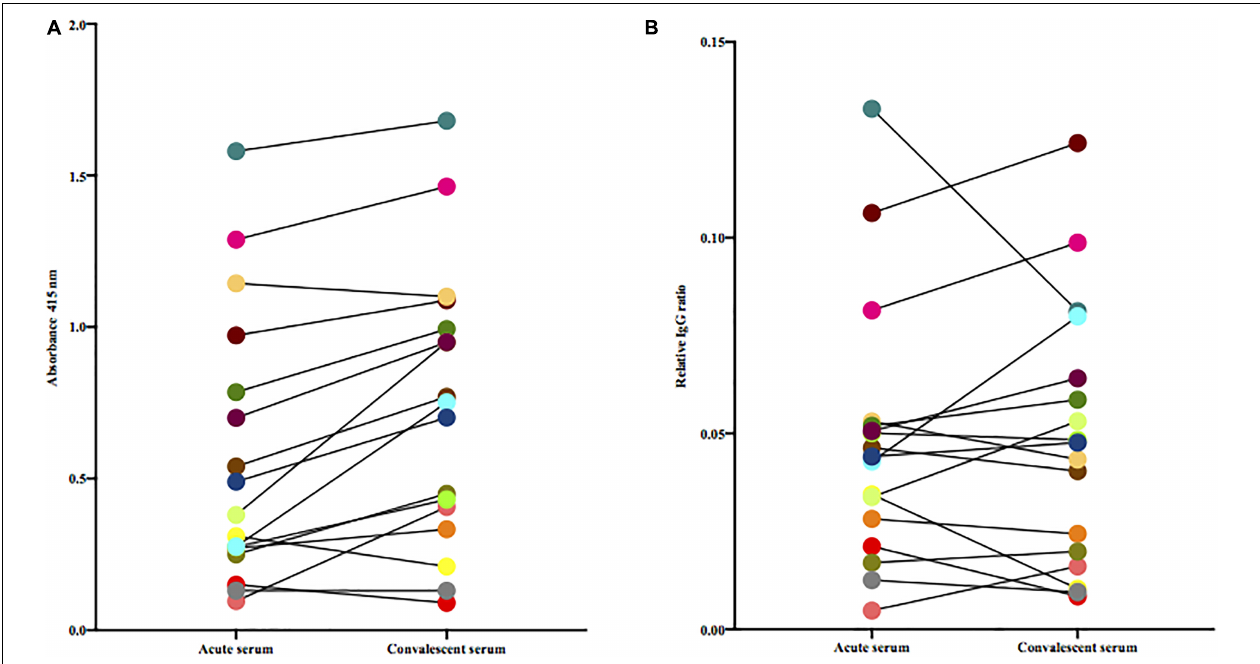
FIGURE 2 | (A) Paired acute and convalescent sera from patients were tested for the presence of antibodies toward the bacterium isolated from the same patient. Statistical difference was assessed using Wilcoxon matched-pairs signed-rank test. (B) Paired acute and convalescent sera from patients were tested for the presence of antibodies toward the patient’s own bacterial isolate adjusted for total IgG (Wilcoxon matched-pairs signed-rank